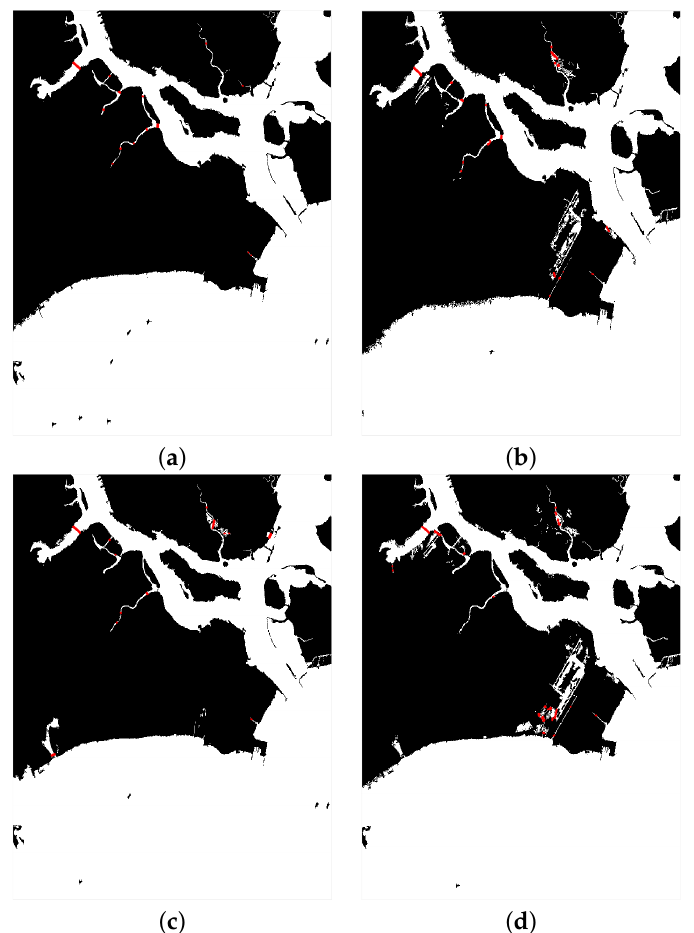
Figure 15. Bridge detection result of quad-polarization and three single-polarization channel data in Singapore using the proposed method, where the binary images are the final water network results and the detected bridges are marked in red: ( a ) result of quad-polarization data; ( b ) result of HH channel data; ( c ) result of HV channel data; ( d ) result of VV channel